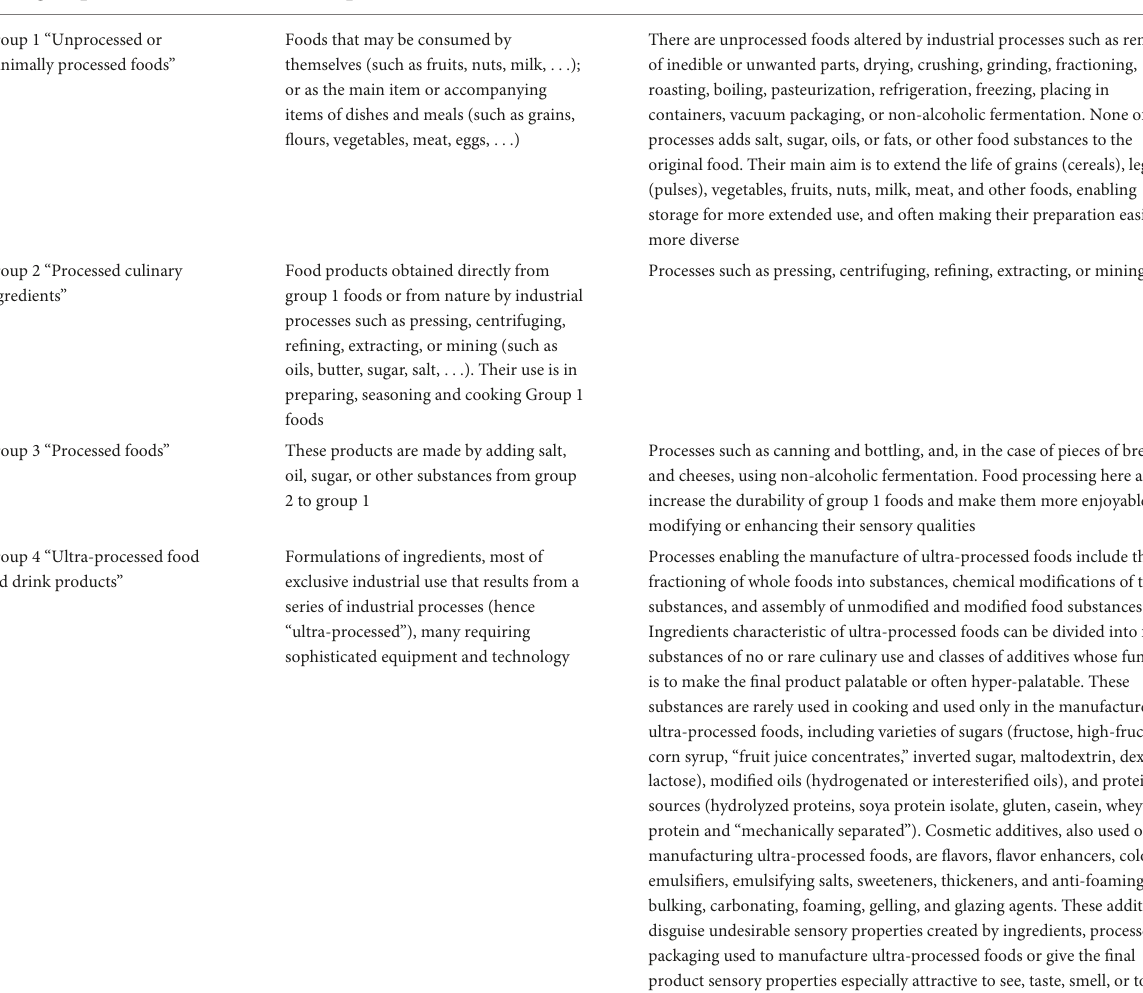
TABLE 2 Description of NOVA foods group (24–27). Nova group